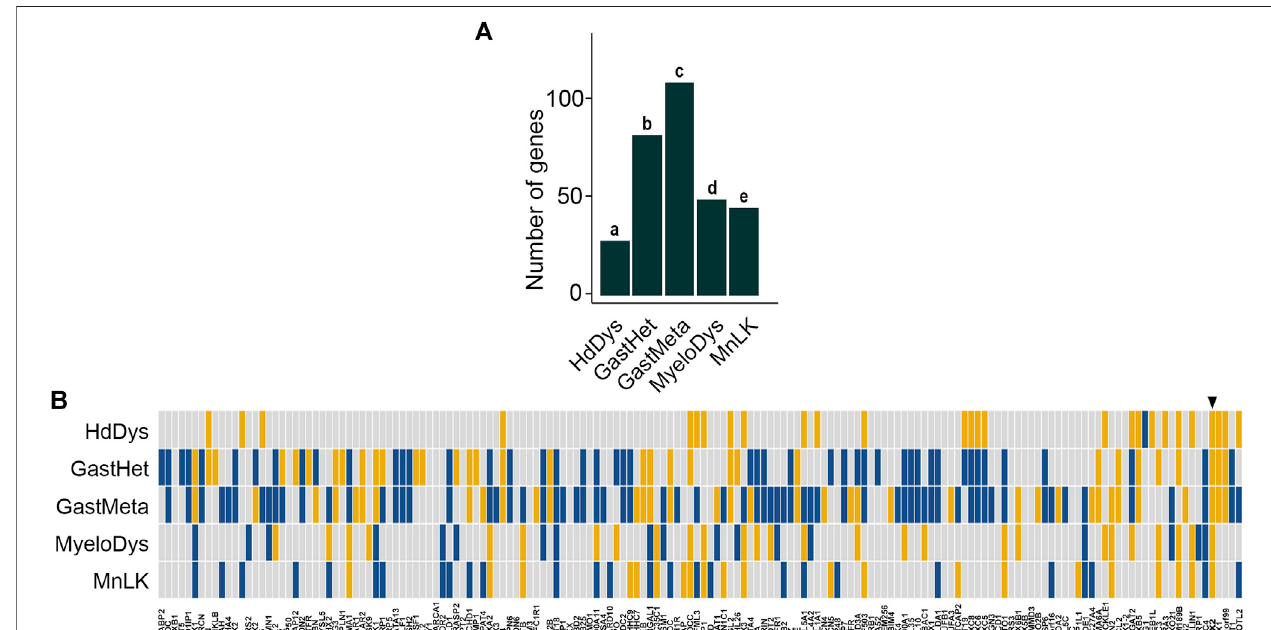
FIGURE3| ValidationofthecoresetofDEGsintransgenicmousemodels.( A )Enrichmentanalysisof162/221genesofthemousecoresetofDEGshavinghuman orthologuesinCdx2-dependenttransgenicmousemodels ofheaddysgenesis (HdDys),gastric-type heteroplasiainthececum(GastHet),gastric-type metaplasiainthe pericecalregion(GastMeta),myelodysplasia(MyeloDys)andmonoblasticleukemia(MnLK). p -valuesarea (cid:1) 5.030 E − 15 ;b (cid:1) 3.020 E − 12 ;c (cid:1) 1.578 E − 18 ;d (cid:1) 4.324 E − 5 ;e (cid:1) 1.546 E − 4 . ( B ) Correlation map of the above 162 genes of the mouse core set of DEGs in the validation models (yellow: up-regulation; blue: down-regulation). In eachcase,themapillustratesthecomparisonoftheCdx2-expressingsamplesvstheCdx2non-expressingcounterparts.ThearrowheadshowsCDX2.Theorderofthe genes is the same as in Figure 1B